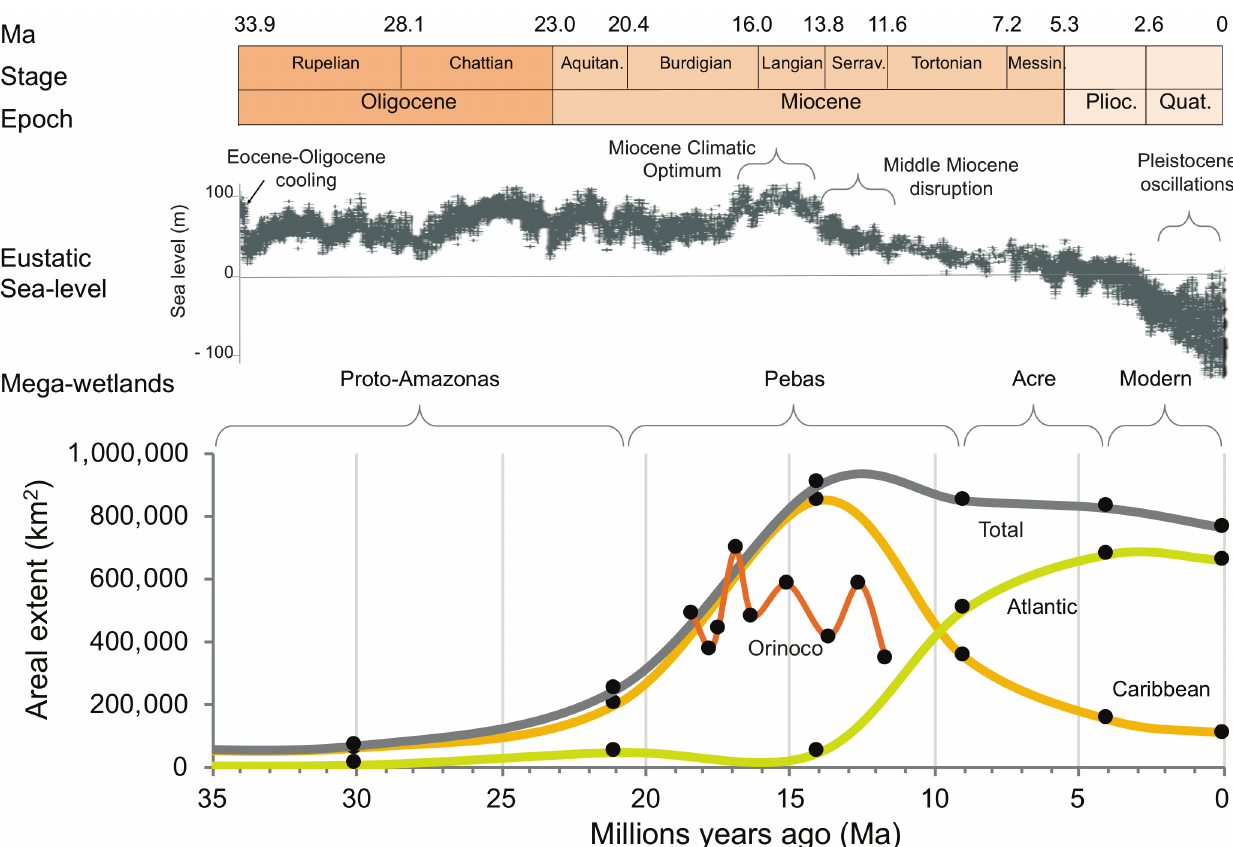
Fig. 7. Growth of mega-wetlands in northern South America. Geological time scale at top. Eustatic sea-level estimates from Zachos et al. (2001). Area estimates of for Atlantic and Caribbean draining mega-wetlands from paleogeographic reconstruc- tions in Wesselingh, Hoorn (2010) and Hoorn et al. (2017), and for the Orinoco basin by Jaramillo et al. (2017). Caribbean- draining Andean foreland basins in orange; Atlantic-draining basins contributing to transcontinental Amazon in yellow. Areas estimated using ImageJ (Abràmoff et al. , 2004). Curves smoothed using a third-order Bezier